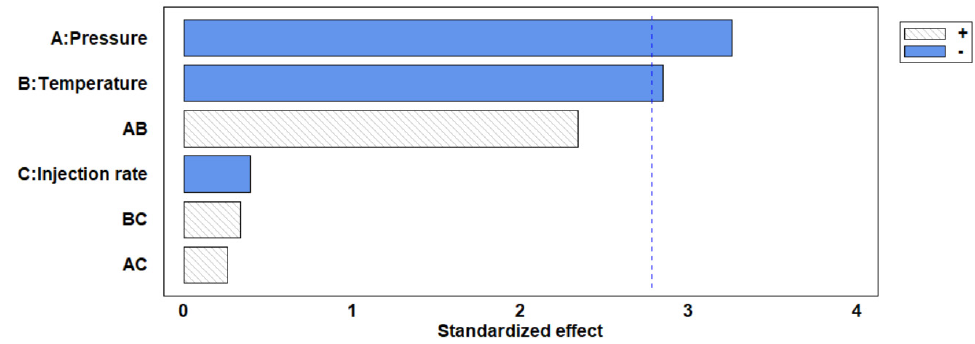
Figure 4. Pareto diagram representing the effect of different parameters on the particle size. “+” (positive effect) “ − ” (negative effect).